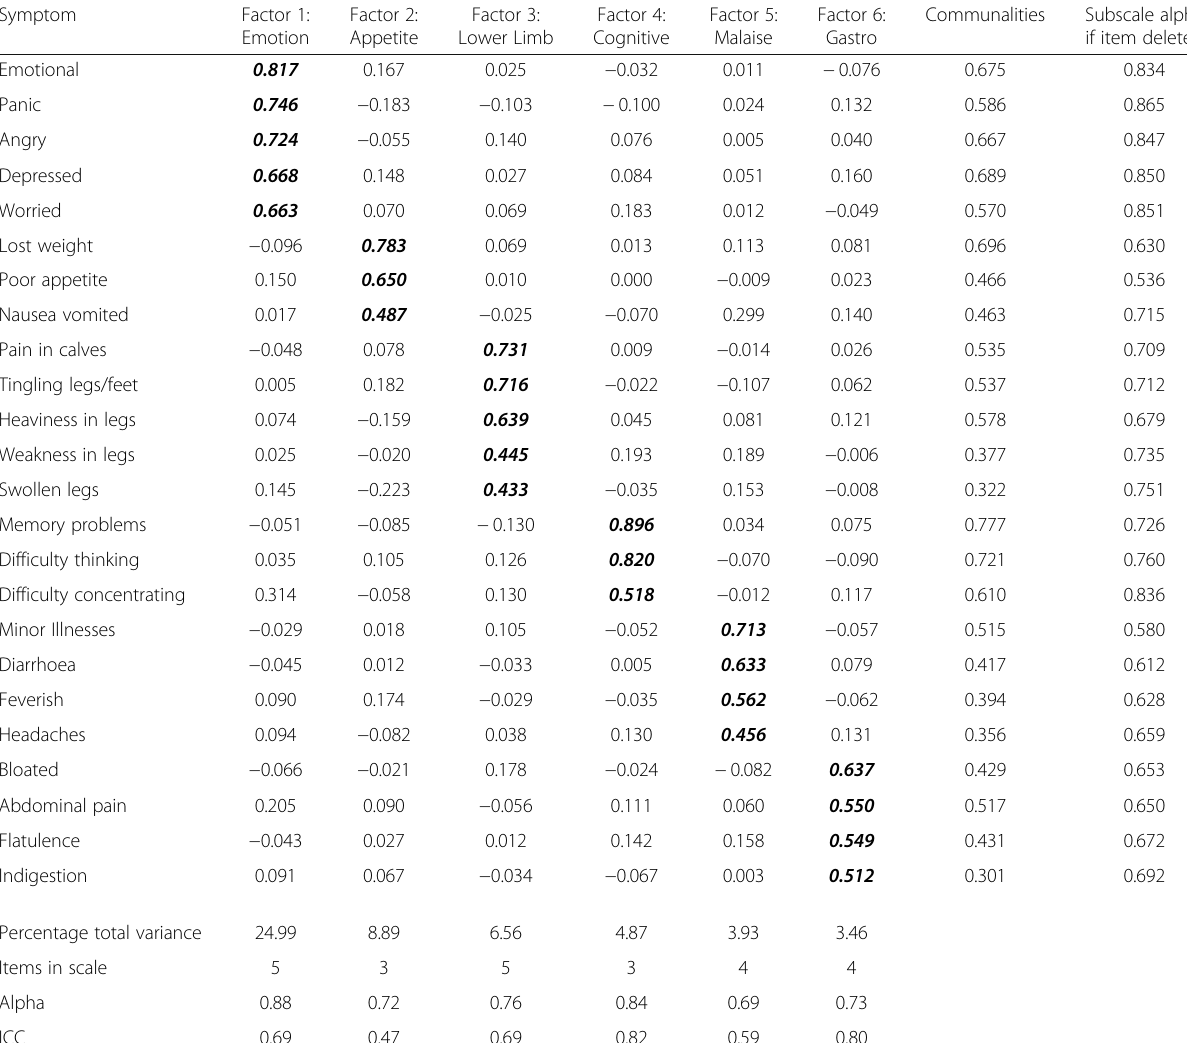
Table 4 AneurysmSRQ Forced six-factor EFA - factor loadings, communalities and reliability coefficients